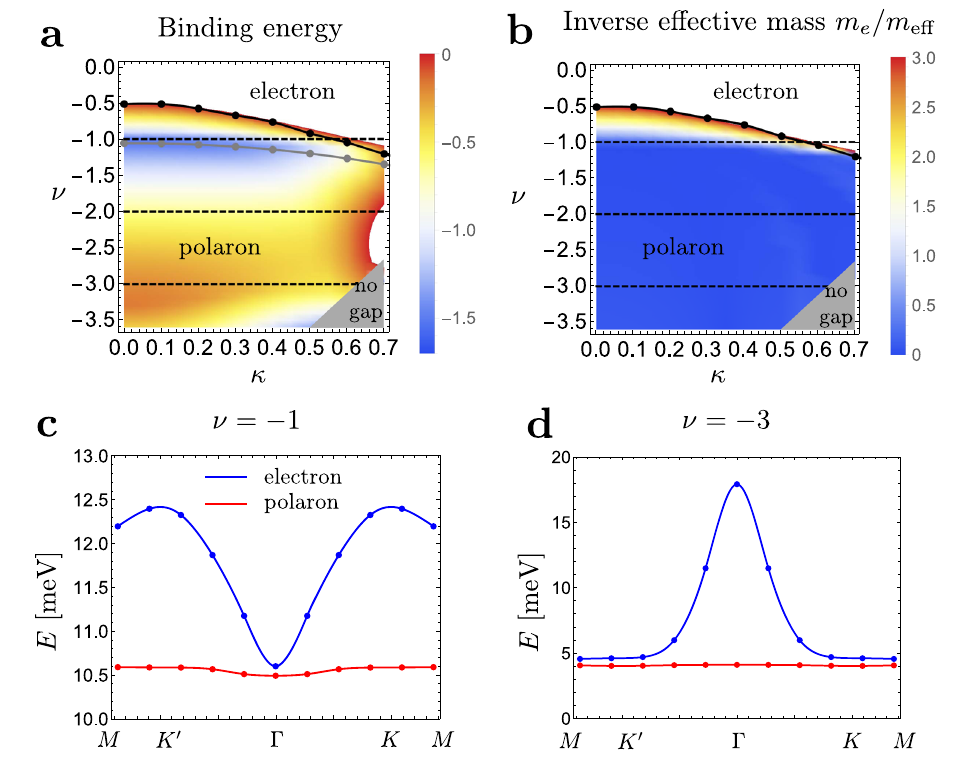
Fig. 3 | Polaron energetics in twisted bilayer graphene. a Binding energy as a function of “ fi lling ” ν and chiral ratio κ . The dashed lines indicate integer fi llings ν whereourdispersionmatchestheHFdispersionforelectrondoping.Aboundstate is only found for ν <0, indicating doping towards neutrality. The solid black line indicates the boundary where the bound state is lost, the dashed gray line